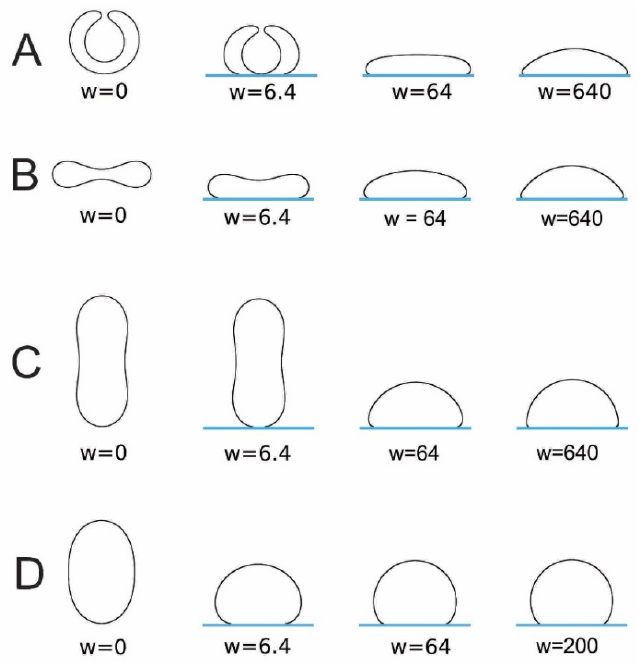
Figure 12. The calculated shapes of free (nonadsorbed) and adsorbed vesicles obtained by the minimization of the free energy given by Equation (18), determined for c 0 = 0 and different values of reduced volume: v = 0.5 ( A ), 0.6 ( B ), 0.8 ( C ), and 0.95 ( D ), and different values of reduced adhesion strength w , defined by Equation